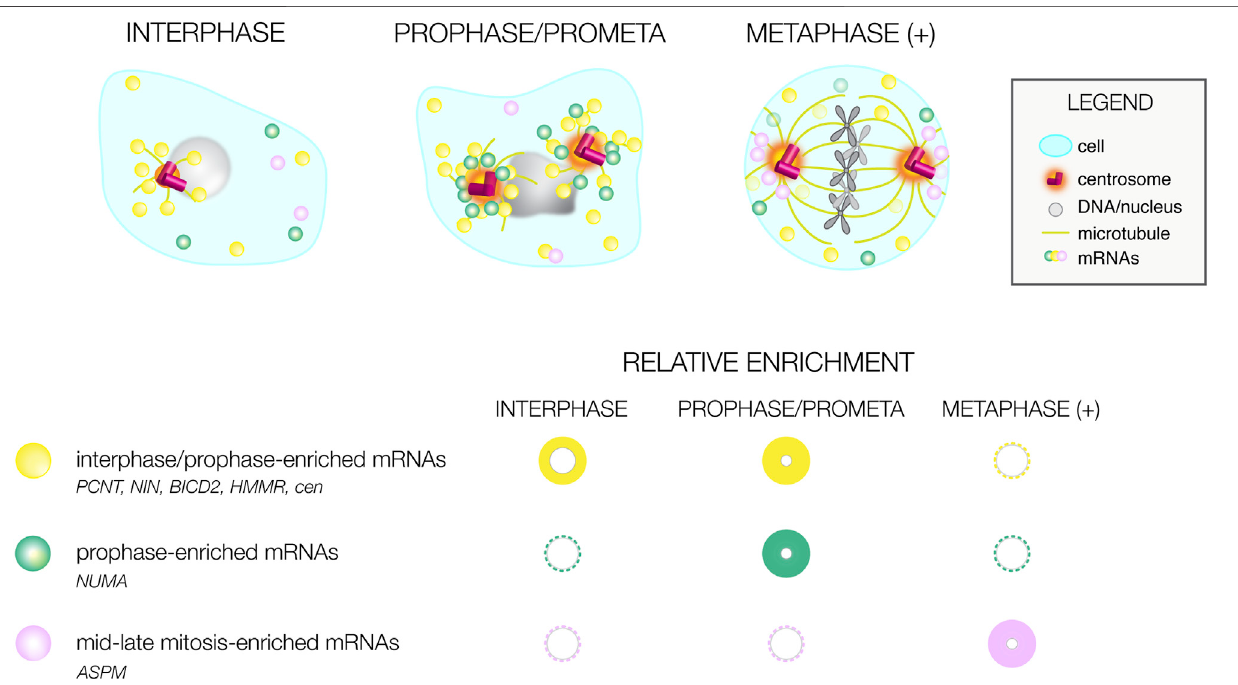
Frontiers in Cell and Developmental Biology |